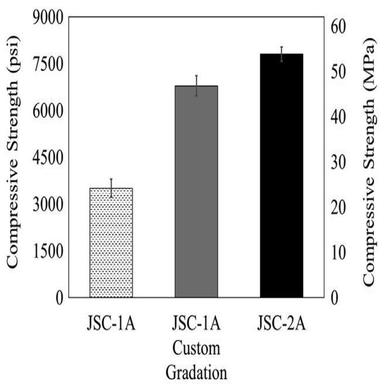
28-day compressive strength comparison of JSC-1A, JSC-1A sieved to match JSC-2A, and JSC-2A.